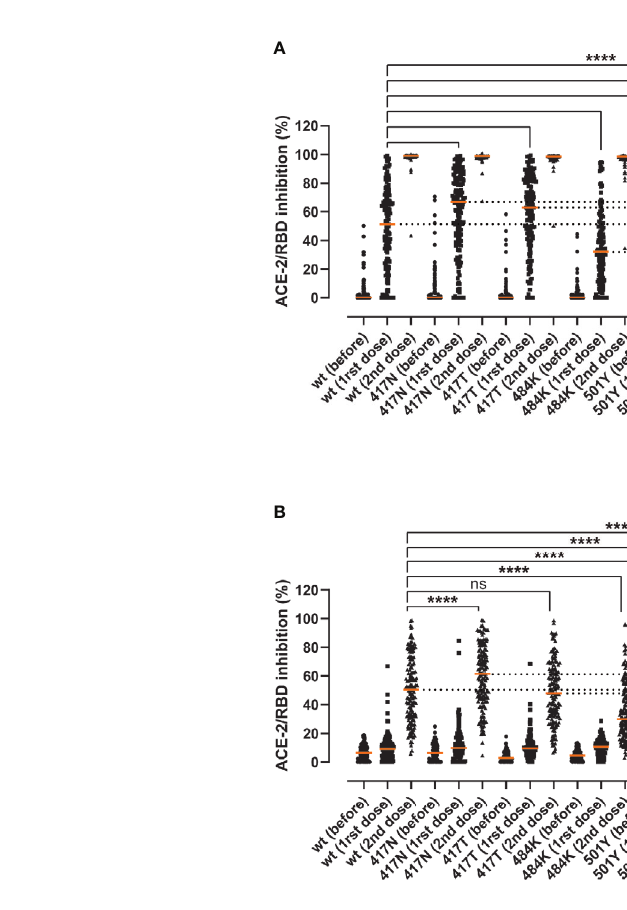
FIGURE 5 | Inhibition capacity of sera from healthy individuals before and after the BNT162b2 vaccine against the RBD variants. Samples were collected immediately before (before), around 3 weeks after the fi rst (1rst dose), and 5 weeks after the second vaccine dose (2nd dose) ( n = 149). Statistical comparisons of the neutralization indexes for the different variants were performed at 10% serum after the fi rst dose (A) or at 0.11% serum after the second dose (B) using the Friedman test with Dunn ’ s multiple comparisons. Orange lines represent medians. The signi fi cance value (**** or ns) re fl ects the pairwise comparisons between the wt and each of the single and combined mutations. Based on the visual and numeral evaluation of the spread of the data, pairwise statistical comparisons after the fi rst dose were performed at 10% serum (A) , while differences after the second dose were evaluated at 0.11% serum (B) . ns, non-signi fi cant; ****, p <